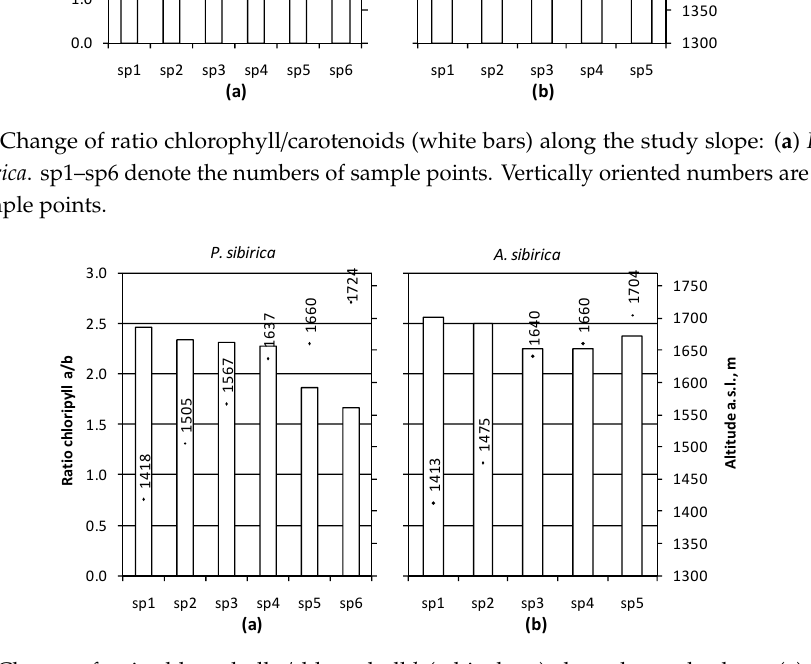
Figure 4. Change of ratio chlorophyll a / chlorophyll b (white bars) along the study slope: ( a ) P. sibirica ; ( b ) A. sibirica . sp1–sp6 denote the numbers of sample points. Vertically oriented numbers are altitudes of the sample points.